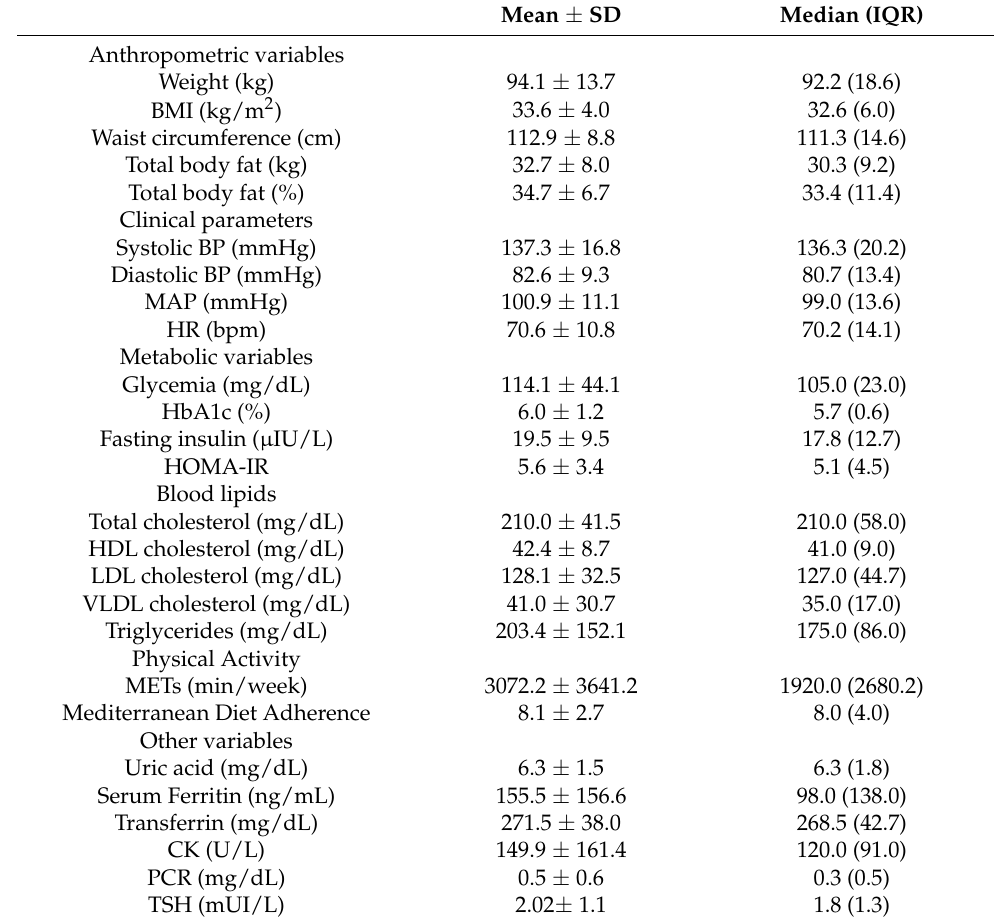
Table 2. Anthropometric, clinical, and metabolic characteristics of the current study population ( n = 75).